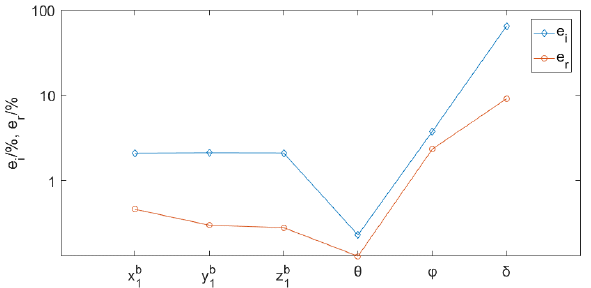
Figure 7. Errors of pose and coaxiality